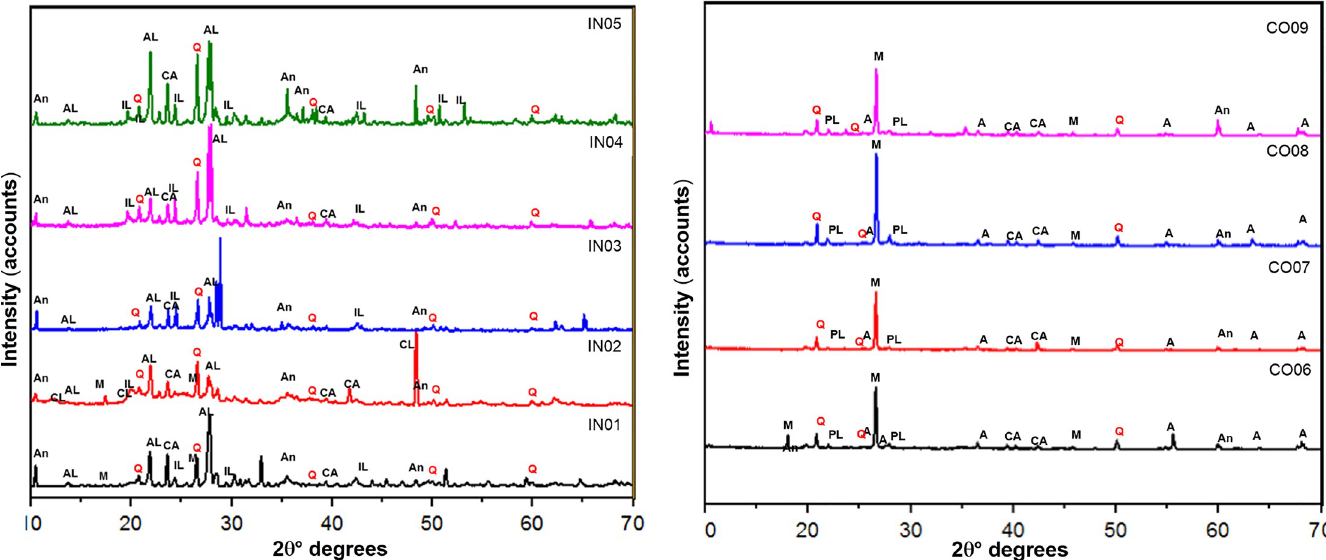
Fig 5. Diffraction patterns obtained from the samples. A. corresponds to fragments IN01, IN02, IN03, IN04 and IN05 and B. corresponds to fragments CO06, CO07, CO08 and CO09. Conventions indicate: An (amphibole: hornblende), PL (plagioclase), M (mica: muscovite), Q (quartz), IL (illite), CL (chlorite), CA (kaolinite), A (anatase), Mt (montmorillonite) and AL